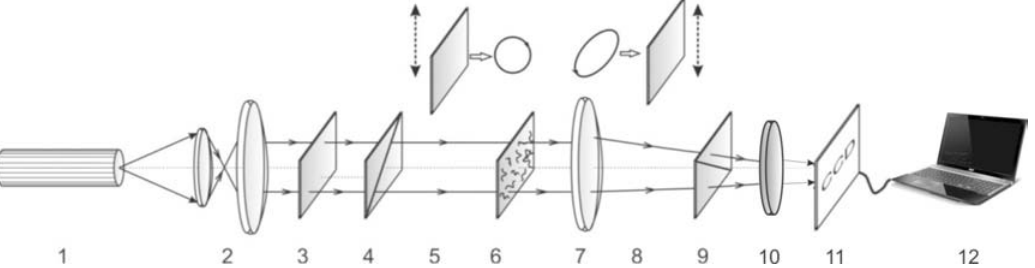
Fig. 1. Optical scheme of Stokes-polarimeter. Explanations are in the